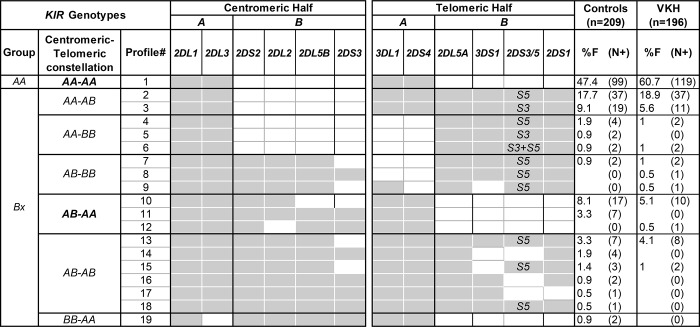
Frequency of KIR genotype profiles in patients with Vogt-Koyanagi-Harada (VKH) disease and healthy controls.Nineteen KIR genotypes were observed that differ from each other by the presence (indicated by grey shading) of 12 variable KIR genes. Genotypes for the centromeric and telomeric parts of the KIR locus were assigned according to the presence or absence of A and B haplotype defining KIR genes. Frame work genes (3DL3, 3DP1, 2DL4, 3DL2) and pseudogene (2DP1) that were observed in all 405 studied subjects are not shown. The frequency of each genotype is presented in percentage frequency (%F) and defined as the number of individuals carrying the genotype (N) divided by the number of individuals studied (n) in the given study group. Significant difference between controls and patients was observed only in the distribution of genotypes with AA-AA (p = 0.007) or AB-AA (p = 0.05) constellations.